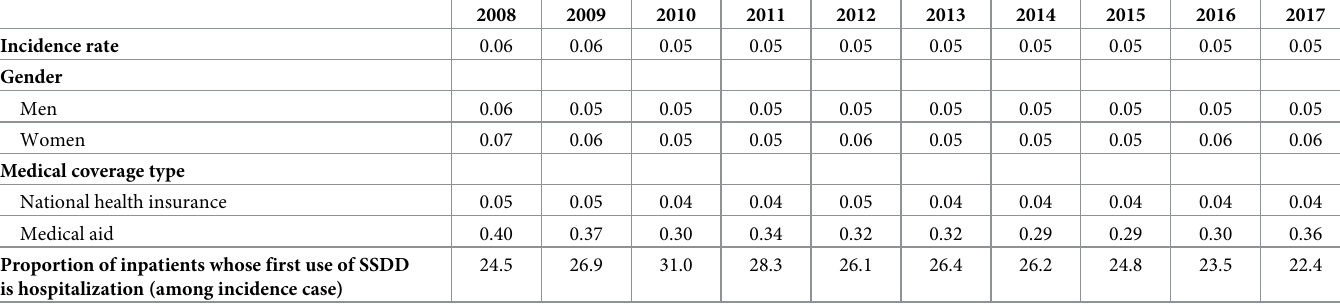
Table 4. Incidence rate and admission rate for first use of health services for schizophrenia, schizotypal and delusional disorders,